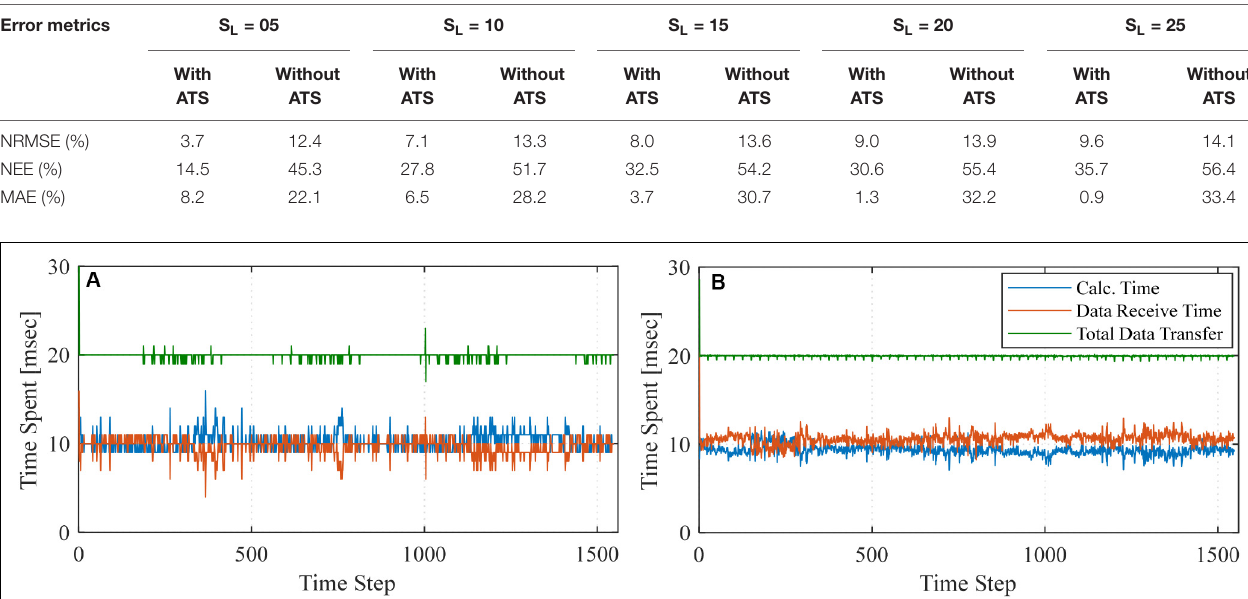
FIGURE 20 | Computational time for RTHS tests with Model 1 located at (A) local PC and (B)